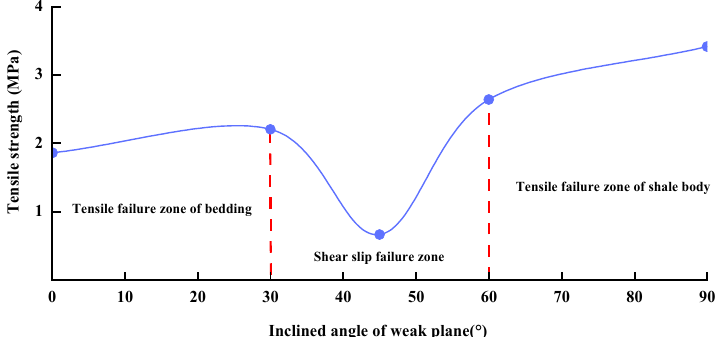
Figure 4. The relationship between the tensile strength and the angle between the loading pressure direction and the bedding direction.